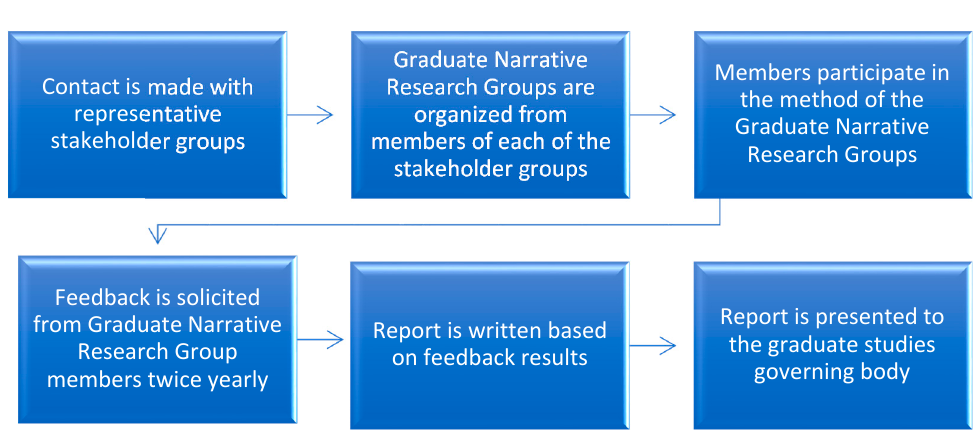
Figure 3. Process followed by the facilitator in setting up and administering Graduate Narrative Research Groups, gaining feedback and, as a result of the process, writing and presenting a report on the results to the university’s graduate studies governing body.